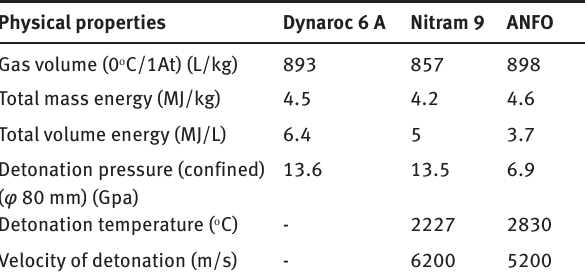
Table 2: Calculated theoretical specifications [44] .